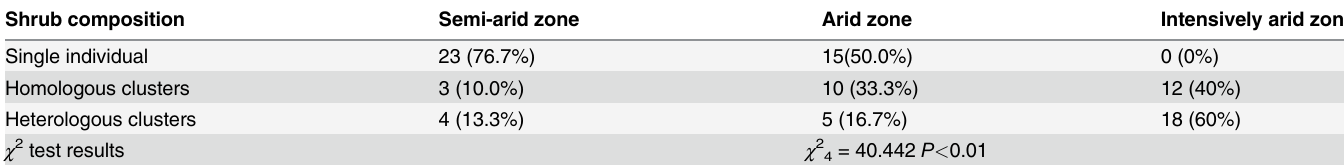
Table 2. Abundances and proportions (in parentheses) of single individuals, homologous clusters and heterologous clusters of C . stenophylla in the semi-arid, arid and intensively arid zones. Shrub composition Semi-arid zone Arid zone Intensively arid zone Single individual Homologous clusters Heterologous